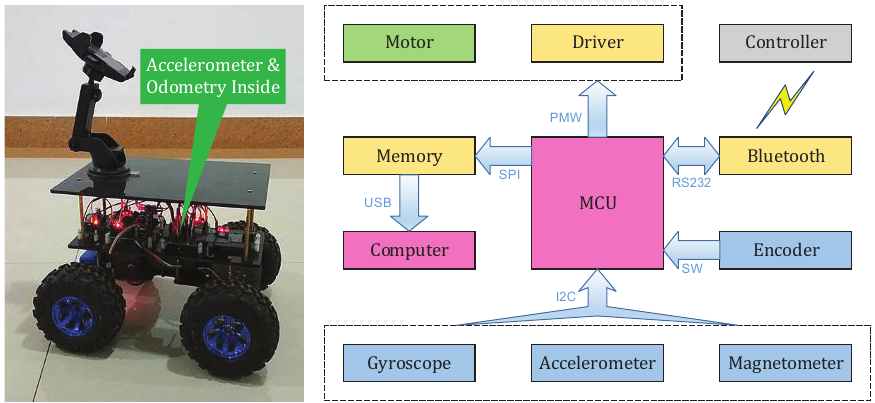
Figure 3. The photograph and electronic system structure of the experimental four-wheeled mobile robot.